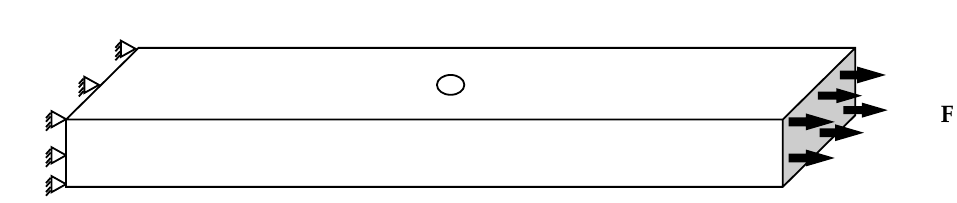
Figure 19. The geometry and boundary conditions of the specimen.